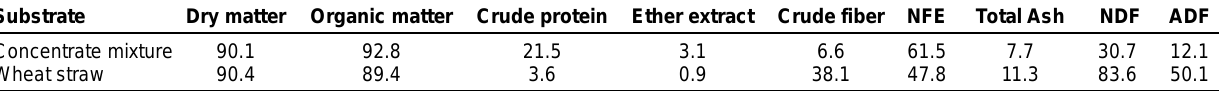
Table-1: Chemical compositions (%DM) of concentrate mixture and wheat straw Substrate